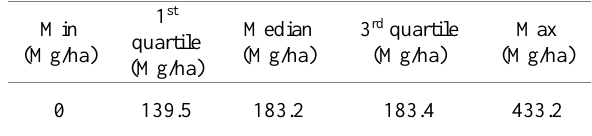
Table 4 . Statistical characteristics of AGB of CFI plots in HWF used for AGB estimation using decision tree-based models and remote sensing data.